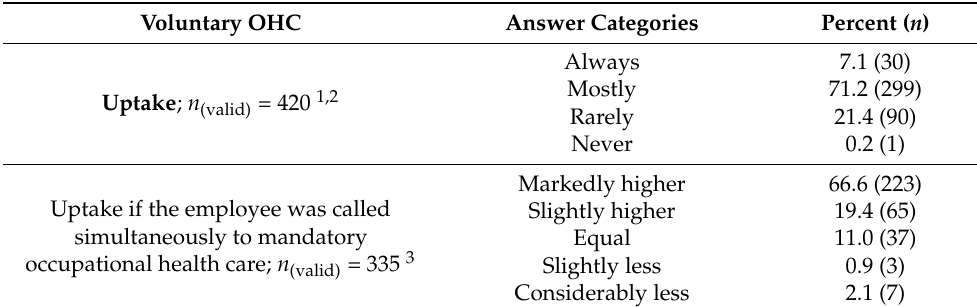
Table 4. Uptake of voluntary occupational health care by employees, if provided by employer— assessment of occupational health